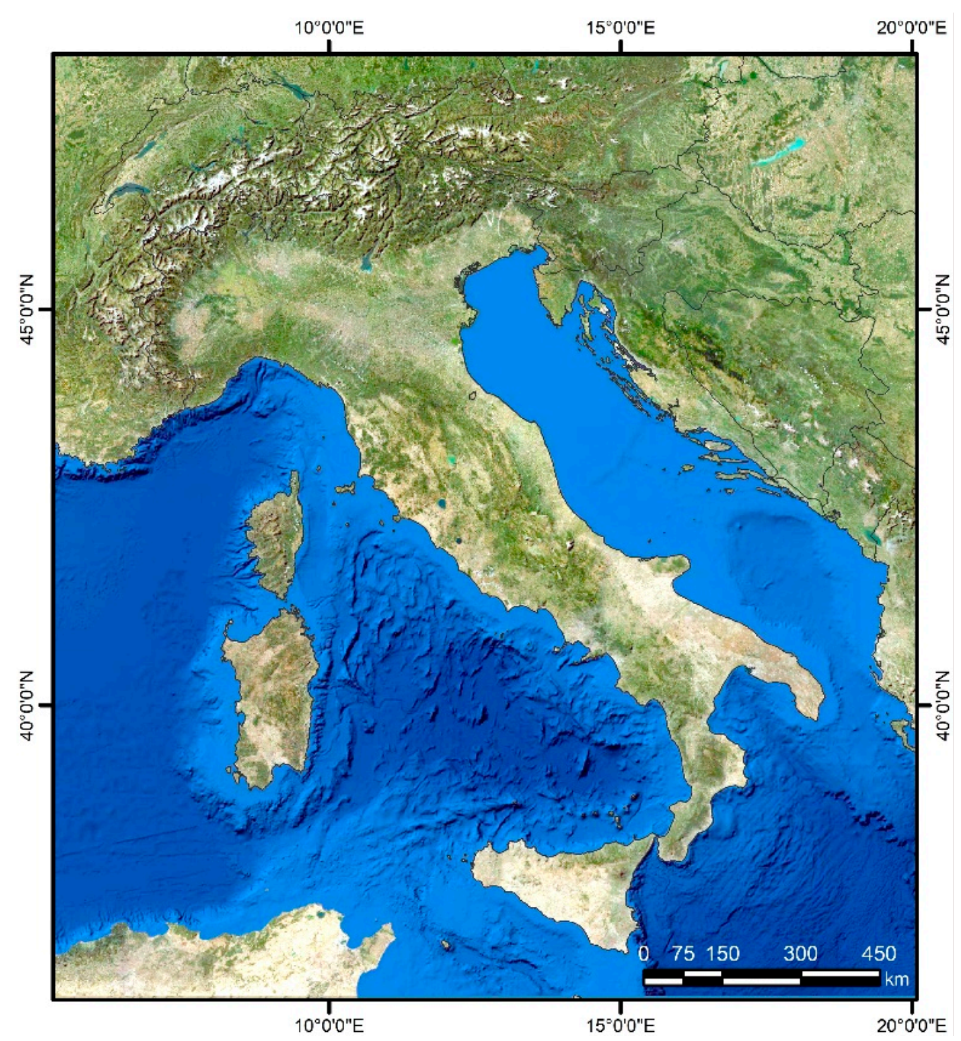
Figure 2. Study area.